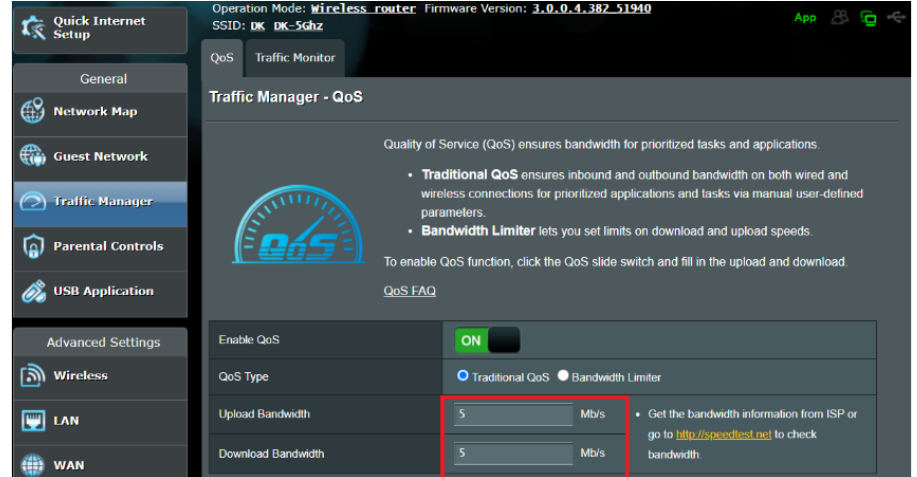
Figure 16. Access point (AP) configuration for A-IVI testbed .